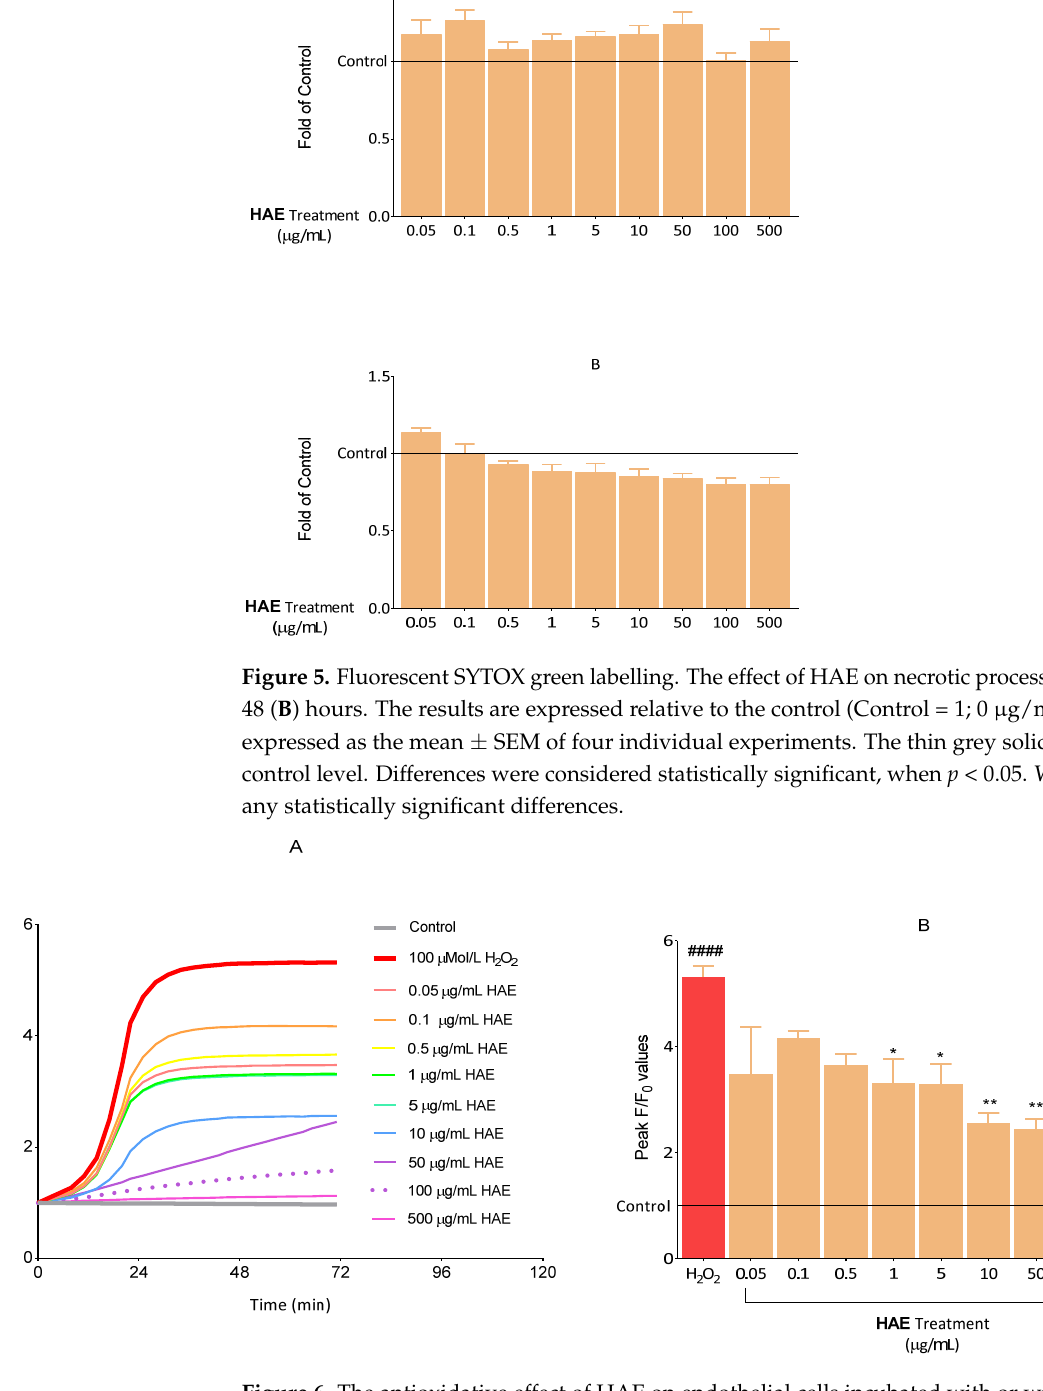
Figure 6. The antioxidative e ff ect of HAE on endothelial cells incubated with or without 100 µMol/L H 2 O 2 . To label intracellular ROS the cells were exposed to 100 µMol/L DCFDA for 1 h at 37 °C. Fluorescent intensity was normalised to the baseline ( A ). Statistical analysis was performed at the peak fluorescence (F/F0) values ( B ). Data are expressed as the mean ± SEM. #### mark significant ( p < 0.0001) differences between control and H 2 O 2 group, * ( p < 0.05), ** ( p < 0.01), *** ( p < 0.001) mark significant differences between H 2 O 2 and H 2 O 2 + HAE groups. H 2 O 2 : hydrogen-peroxide.